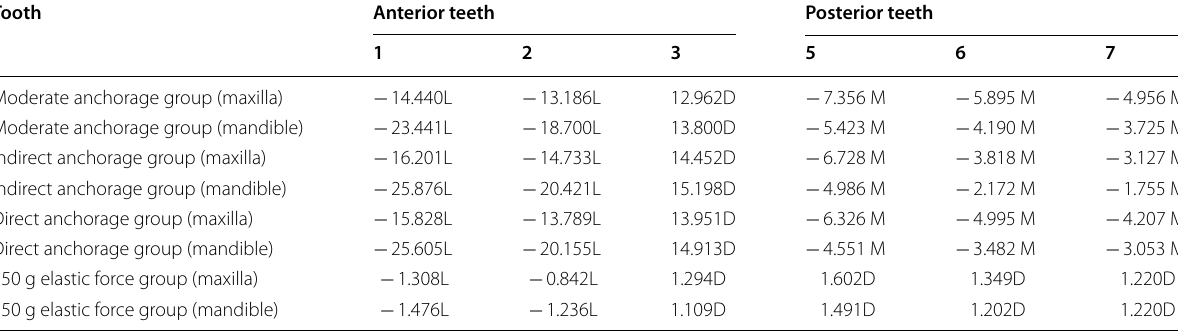
Values indicate the tipping movement in the buccal or distal direction ( + is also marked after the value. B, buccal movement; L, lingual movement; M, mesial movement; D, distal movement. 1, central incisor; 2, lateral incisor; 3, canine; 5, second premolar; 6, first molar; 7, second molar. The calculation of buccal/lingual and mesial/distal tipping change is described in the Methodology section